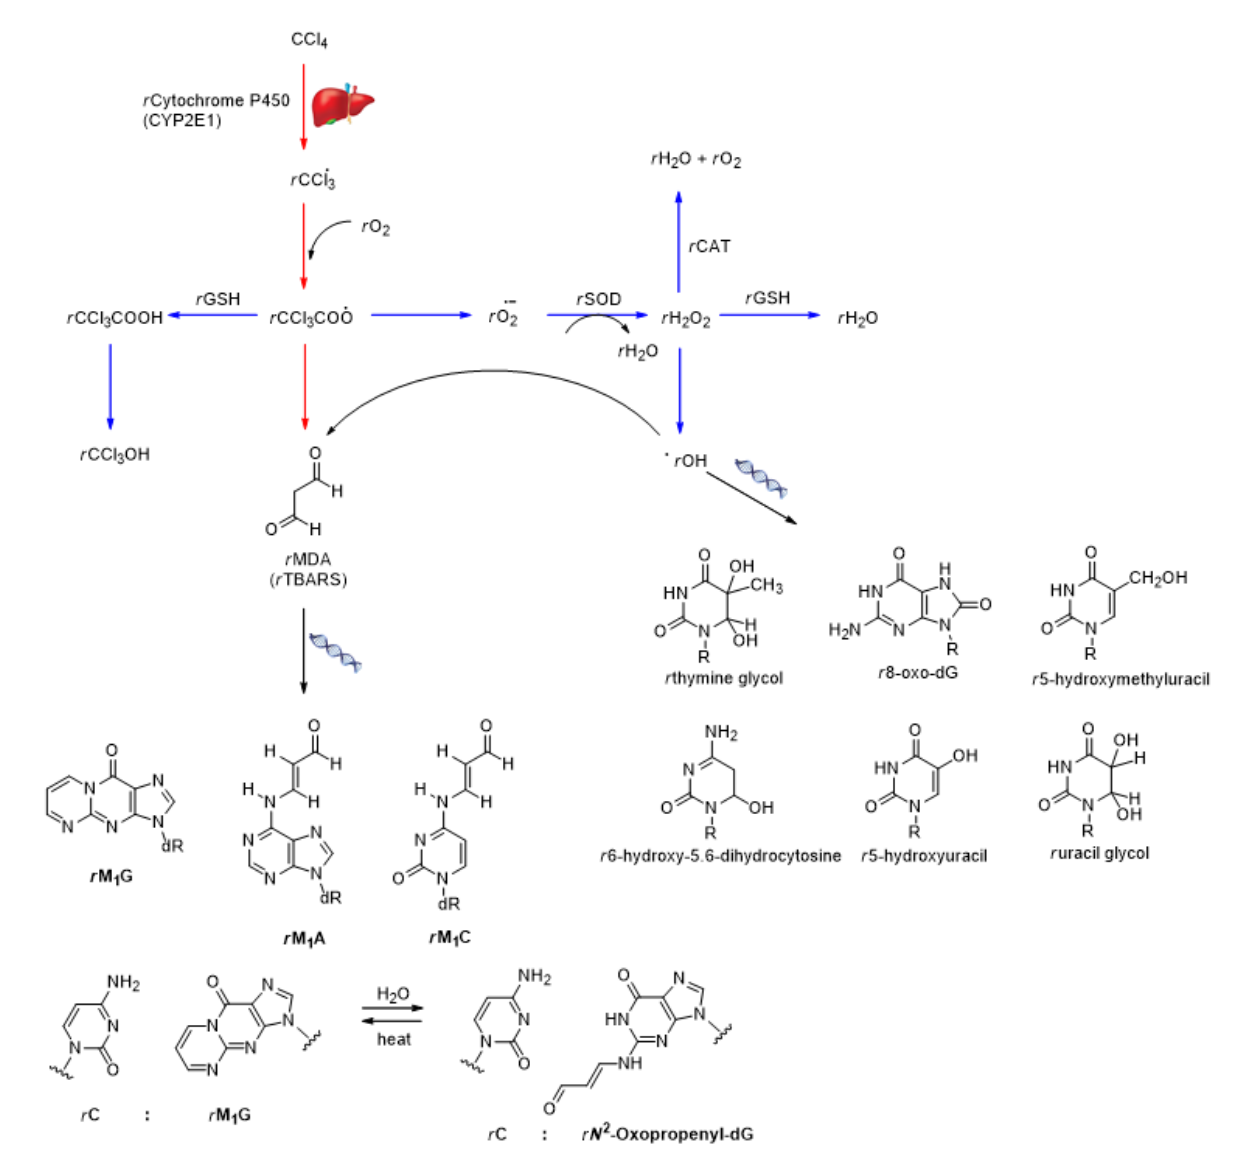
Scheme 1. The implications of CCl 4 administration to cell membrane and